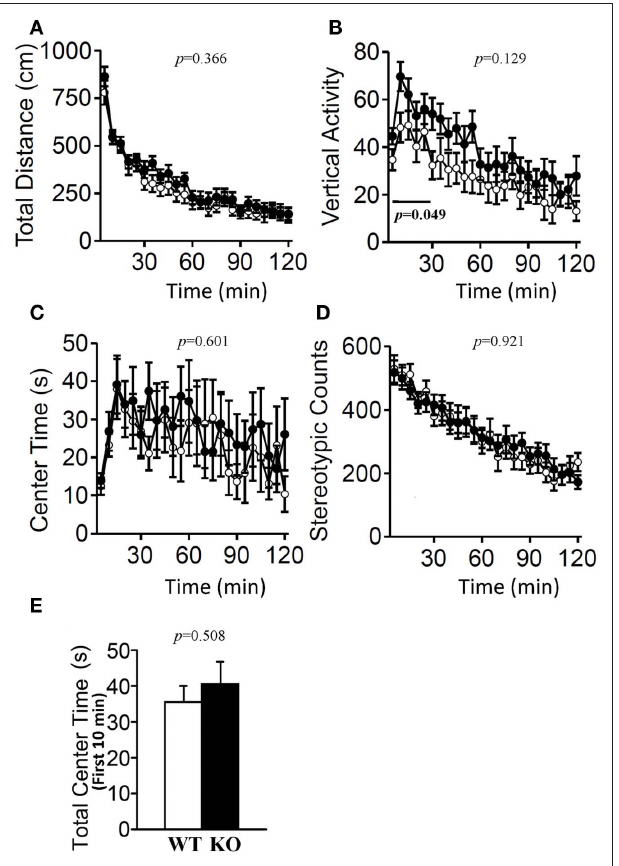
Figure 4 | Open field test. Total locomotion distance traveled (A) , vertical activity (B) , time spent in the center of the compartment (C) , and stereotypic behavior (D) were recorded. Data are presented as mean ± SEM ( n = 20 each). p -Values indicate significance of genotype effect in two-way repeated measures ANOVA. The vertical activity during the first 30 min (bar) was statistically significant ( p = 0.049). (e) Data of the time spent in the central area during the first 10 min were also statistically analyzed using Student’s